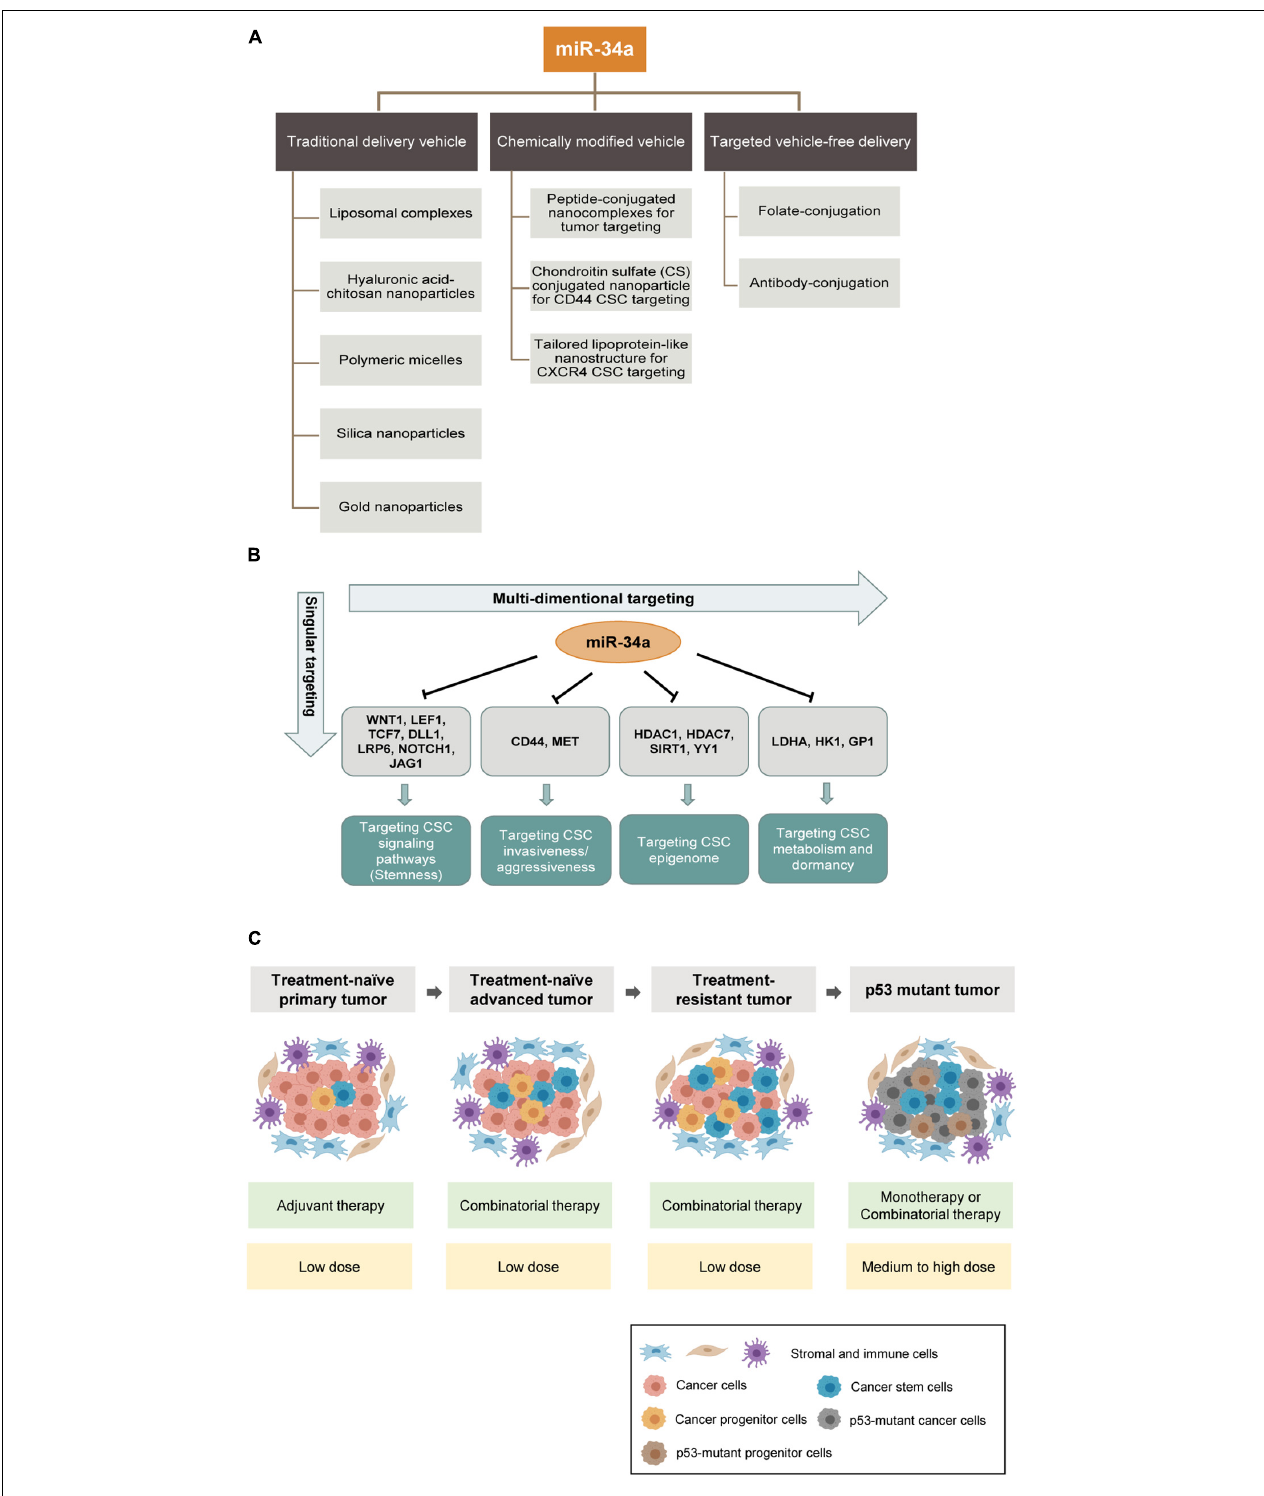
FIGURE 5 | MicroRNA-34a-based therapeutic strategies. (A) Shown are three main categories of preclinical miR-34a delivery platforms: conventional delivery vehicles, chemically modified vehicles and targeted vehicle-free delivery. Some examples are shown below. (B) Current anti-CSC therapeutic strategies primarily target a singular aspect of CSCs. In contrast, miR-34a based therapy can potentially offer multidimensional antitumor effects because of its wide range of targets. (C) Potential clinical settings in which miR-34a mimics can be deployed as an anticancer therapeutic. The miR-34a based therapeutic strategies are shown in green boxes and dosing recommendations of miR-34a are indicated in yellow boxes